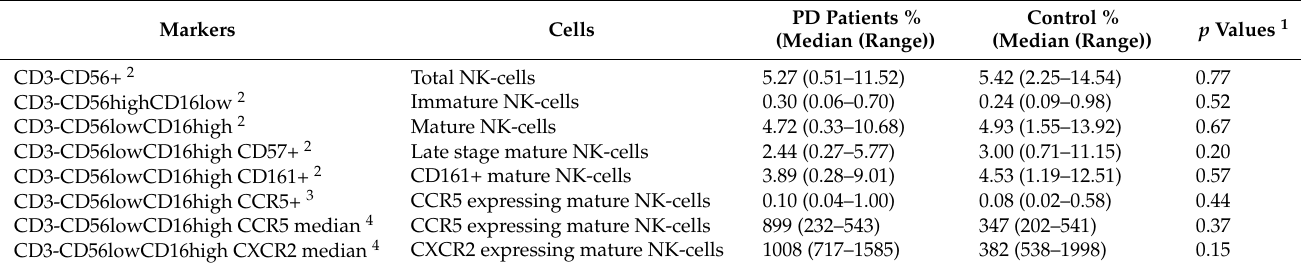
Table 1. Frequencies of NK-cells in PD and expression of CCR5 and